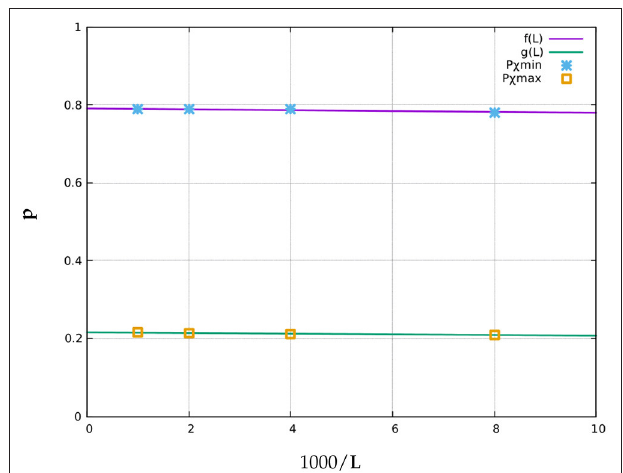
FIGURE 13 | Finite size-scaling on the maxima p χ max (squares) and minima p χ min (star symbols) of the Euler number curves for system sizes L = 125,250,500, and 1000. Here f ( L ) = 0.7906 − 0.0010(1000 / L ) and g ( L ) = 0.2303 − 0.0027(1000 / L